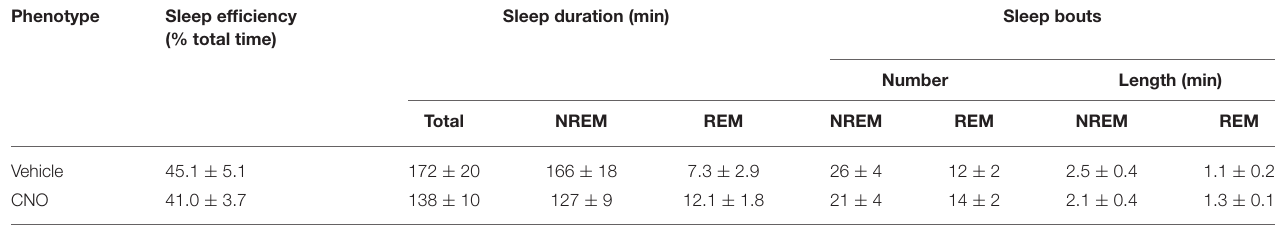
TABLE 2 | Sleep architecture in lean and diet-induced obese C57BL/6J mice. Phenotype